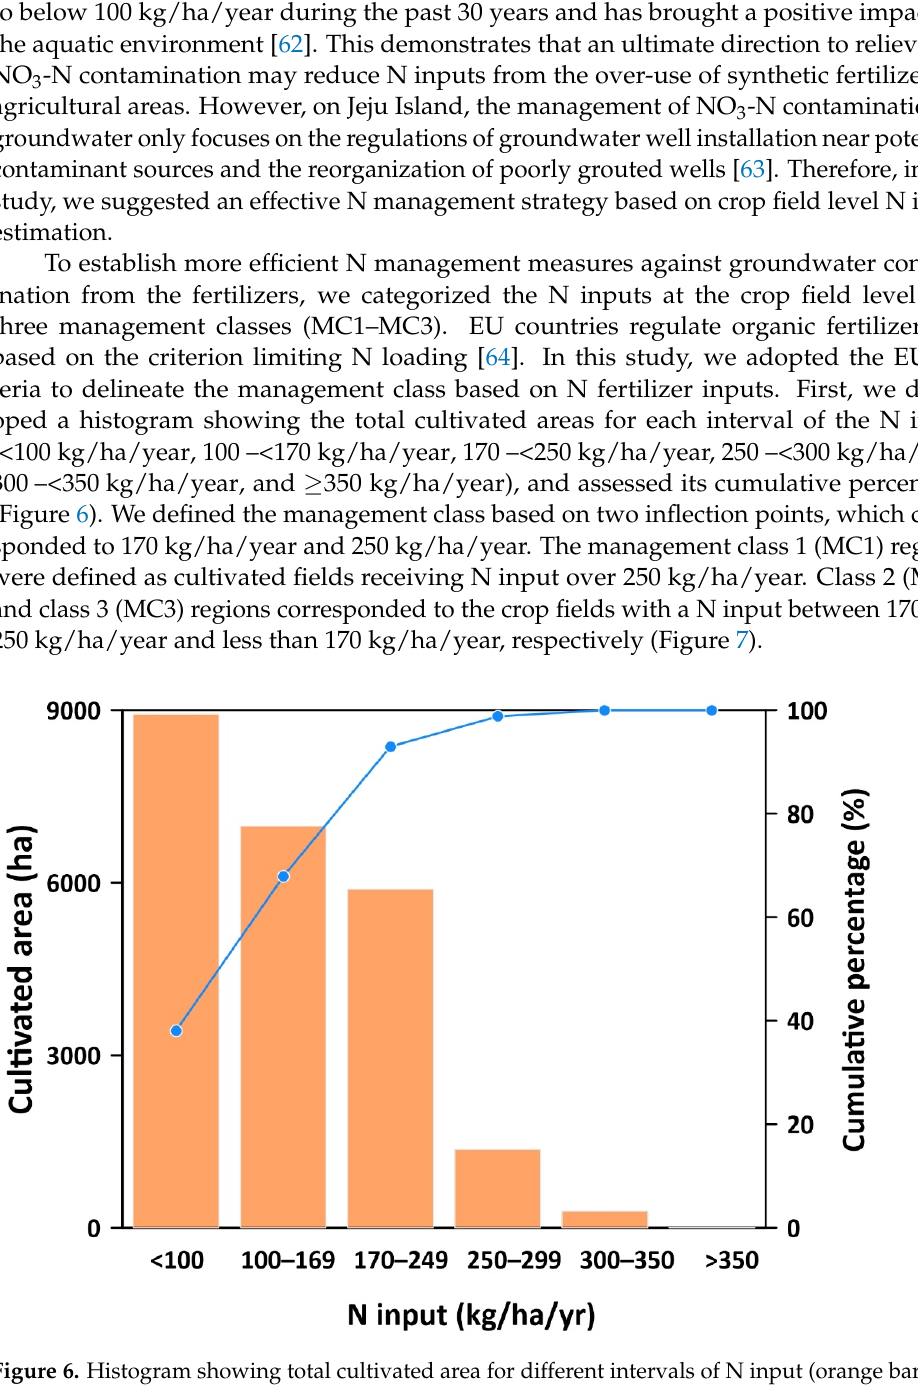
Figure 7. Suggested management zones for controlling N fertilizer use. The MC1 regions (total area: 1024 ha) are most likely to impose NO 3 ‐ N pollution on groundwater; thus, the reinforced NO 3 ‐ N management plans need to be implemented, including (1) a restriction on the cultivation of crops that require a high amount of ferti ‐